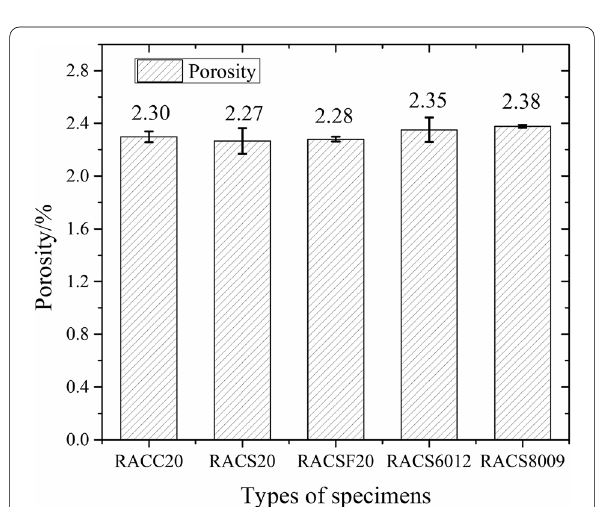
Fig. 6 Influence of admixtures and curing conditions on